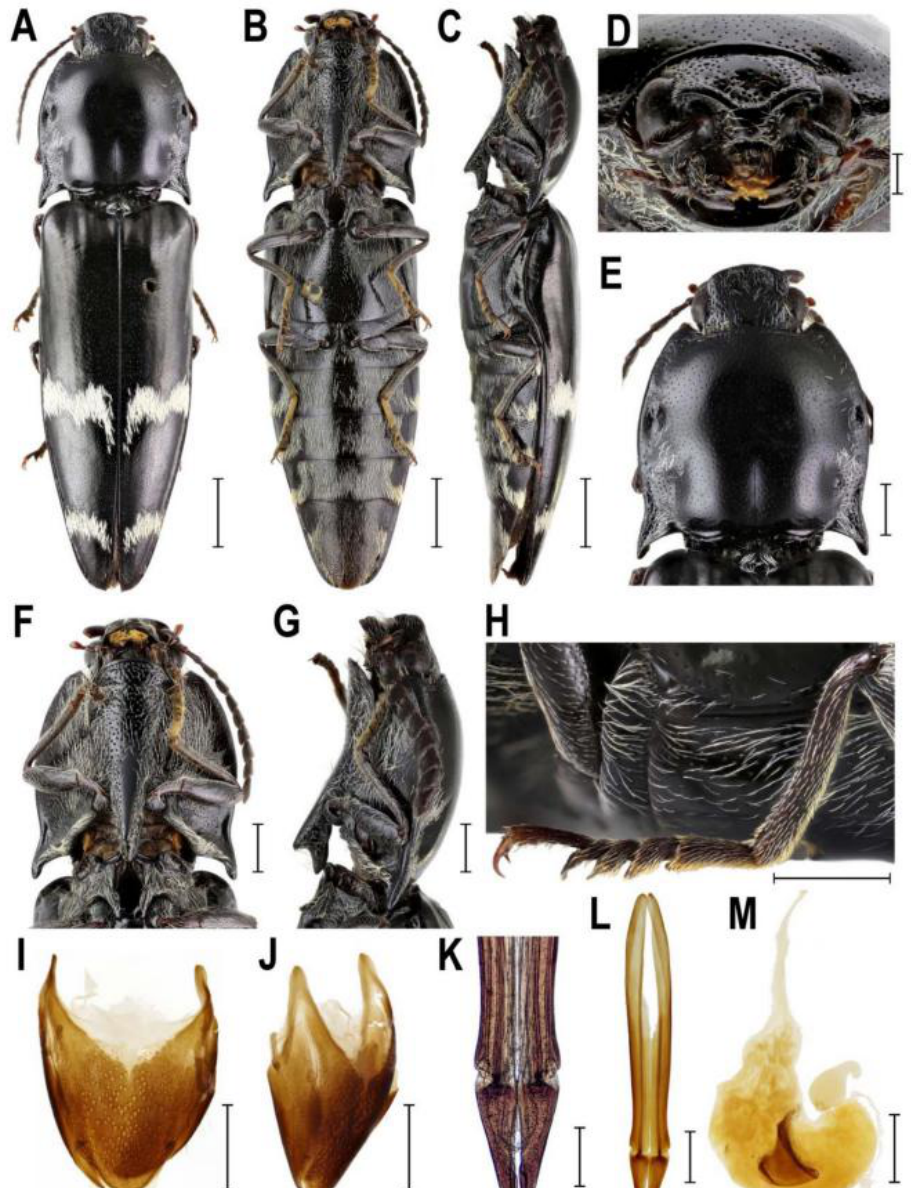
Figure 5. Morphology of Rostricephalus vitalisi , Vietnam, female. ( A ) habitus, dorsal view; ( B ) habitus, ventral view; ( C ) habitus, lateral view; ( D ) head, frontoventral view; ( E ) pronotum, dorsal view; ( F ) prosternum, ventral view; ( G ) prosternum, lateral view; ( H ) right metatibia and metatarsus; ( I ) abdominal sternite VIII, dorsal view; ( J ) abdominal sternite VIII, lateral view; ( K ) apical part of ovipositor; ( L ) ovipositor; ( M ) bursa copulatrix. Scale bars = ( A – C ): 2 mm; ( E – J , L – M ): 1 mm; ( D , K ): 0.5